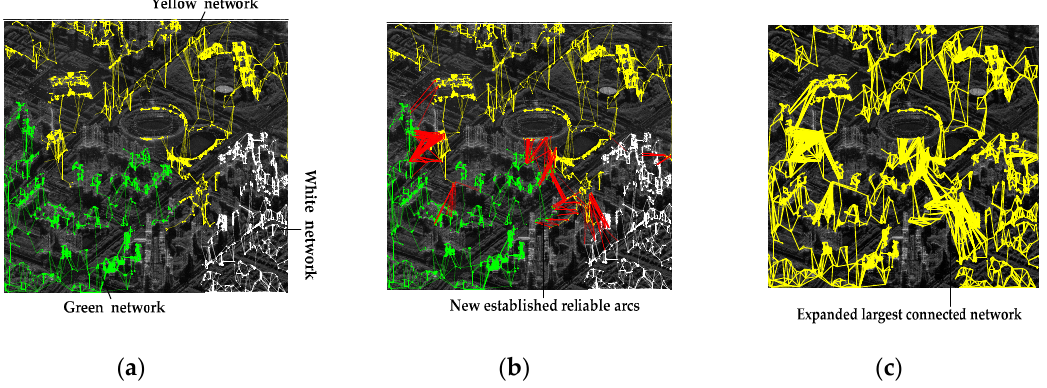
Figure 8. The process of establishing the largest connected network. ( a ) The main isolated networks after network adjustment; ( b ) establishing reliable arcs among the main isolated networks; ( c ) the expanded largest connected network.